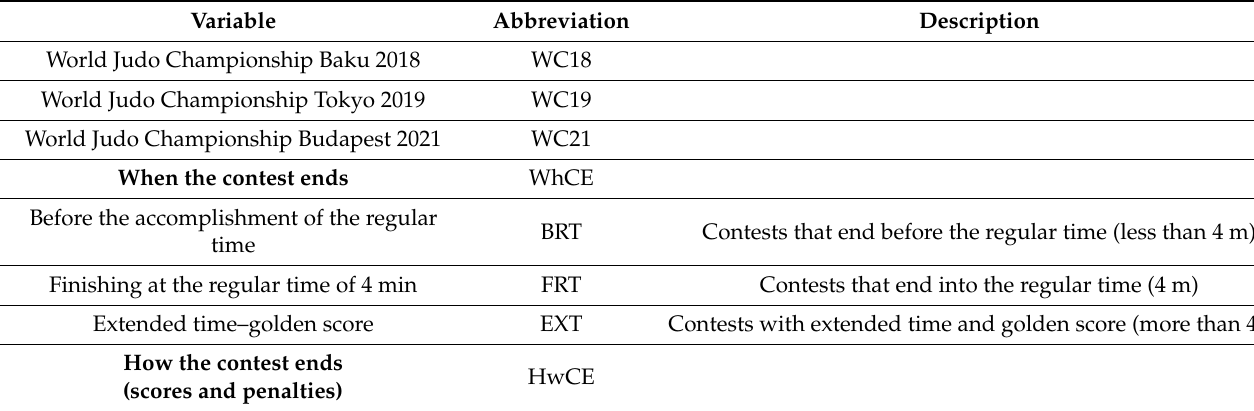
Table 1. Variables of the study and their